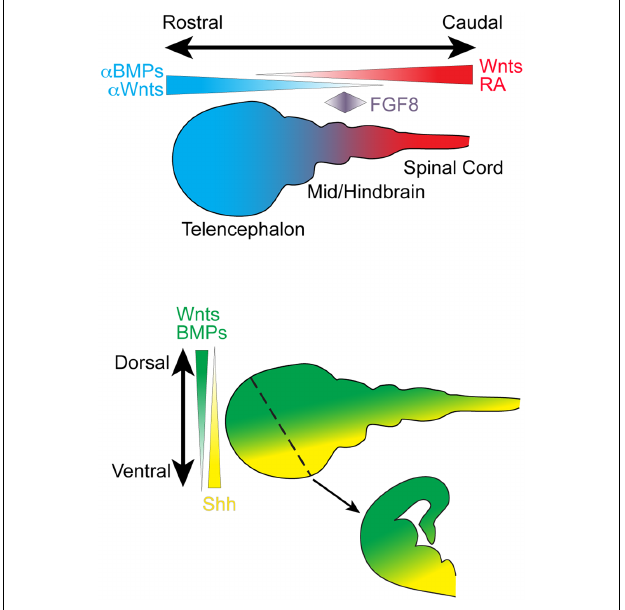
FIGURE 2 | Schematic depicts important secreted signaling factors that pattern the rostro-caudal and dorso-ventral neuraxis during embryonic development. A coronal section through the developing telencephalon is depicted (dotted line, arrow). BMP, bone morphogenetic protein; FGF, fibroblast growth factor; RA, retinoic acid; Shh, Sonic